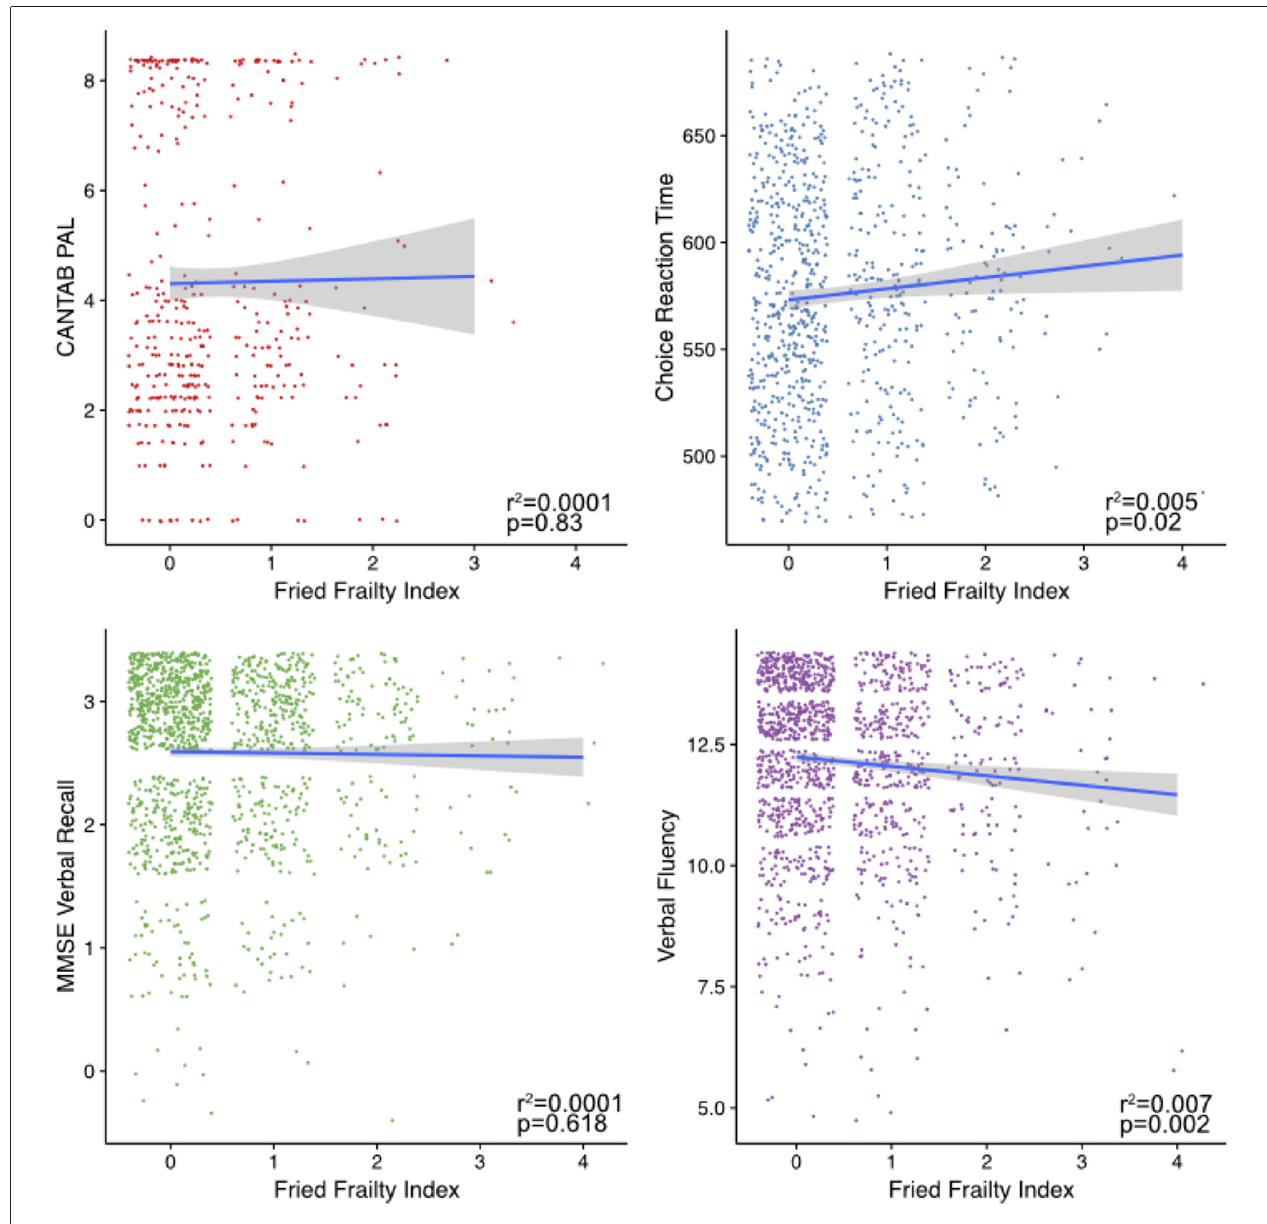
FIGURE 2 | Frailty associations with cognitive phenotypes. Shown are plots of the cognitive measure scores against an individual’s frailty as measure by the Fried index. Fitted lines were made using the geom_smooth command in ggplot2 within R using the “lm” method.